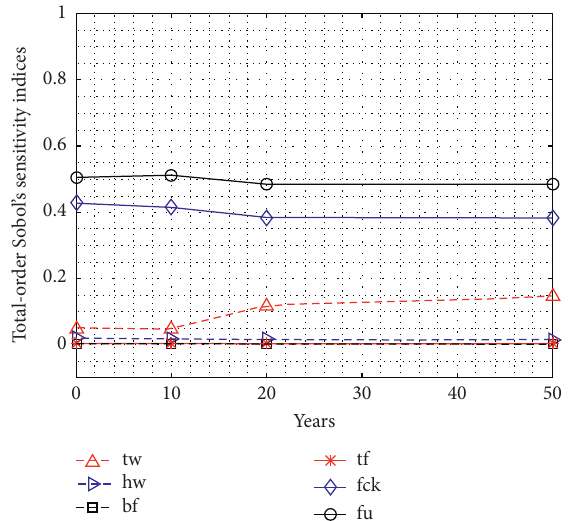
Figure 18: Total-order Sobol’s sensitivity indices of the SCC beams considering 0-year, 10-year, 20-year, and 50-year corrosion